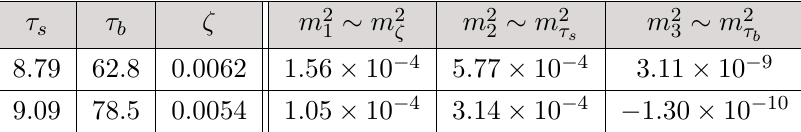
Table 3. Solution and masses (in units of M p ) for the fields ( τ s , τ b , ζ ) for the two parameter sets in table 2. The first solution is metastable, whereas the second has negative m 2 direction.